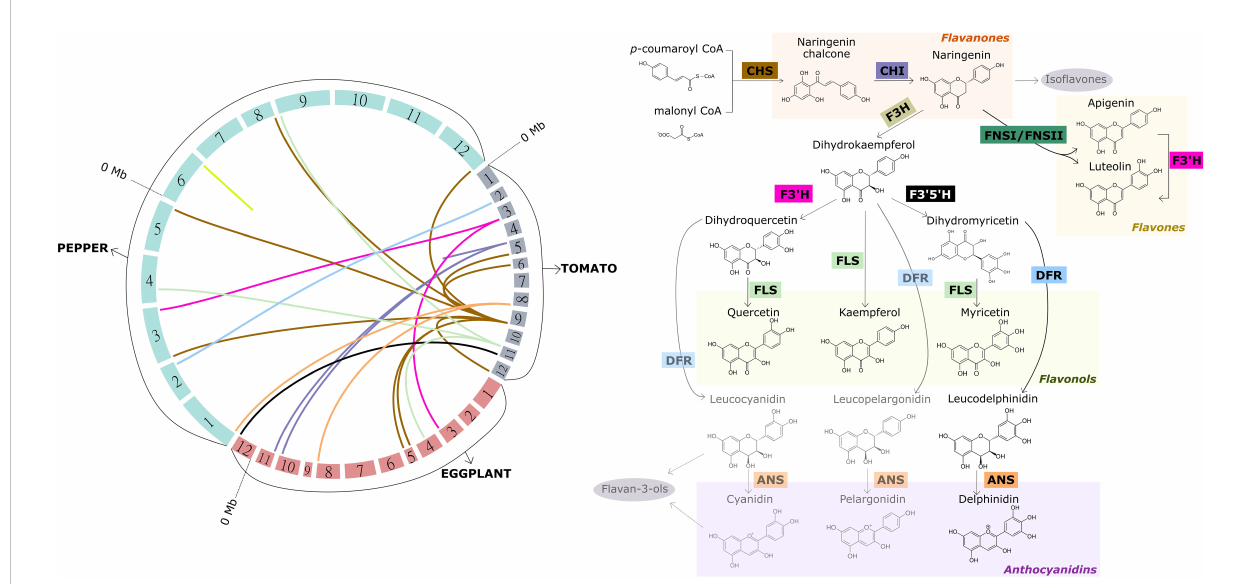
FIGURE 3 Macrosynteny among the tomato, eggplant and pepper genomes for candidate genes encoding the key enzymes involved in the synthesis of major fl avonoids in fruits of these crops other than anthocyanins (left), and overview of the aforementioned synthesis pathway (right). The 12 chromosomes of each of the three genomes represented, which are arranged to form the circle on the left, are colored differently according to the species. The chromosomes are scaled according to their size (Mb). Links with different colors inside the circle were used to connect the physical position of homologous genes within and among the genomes. Same color links represent genes encoding the same key enzyme of the pathway. The acronym of each key enzyme is indicated along the synthesis pathway (right), and framed in the same color as the corresponding link. CHS, chalcone synthase; CHI, chalcone isomerase; F3H, fl avanone-3-hydroxylase; F3 ’ H, fl avanone-3 ’ -hydroxylase; F3 ’ 5 ’ H, fl avonoid-3 ’ ,5 ’ -hydroxylase; FLS, fl avonol synthase; DFR, dihydro fl avonol 4-reductase; ANS, anthocyanidin synthase; FNSI/FNSII, fl avone synthase I/II. The genes used for creating the links resulted from a blastp against the current protein databases of tomato, eggplant and pepper at the Sol Genomics platform (http://www. solgenomics.net). The hits with the lowest e-value, higher sequence size and higher sequence identity (>70%) were